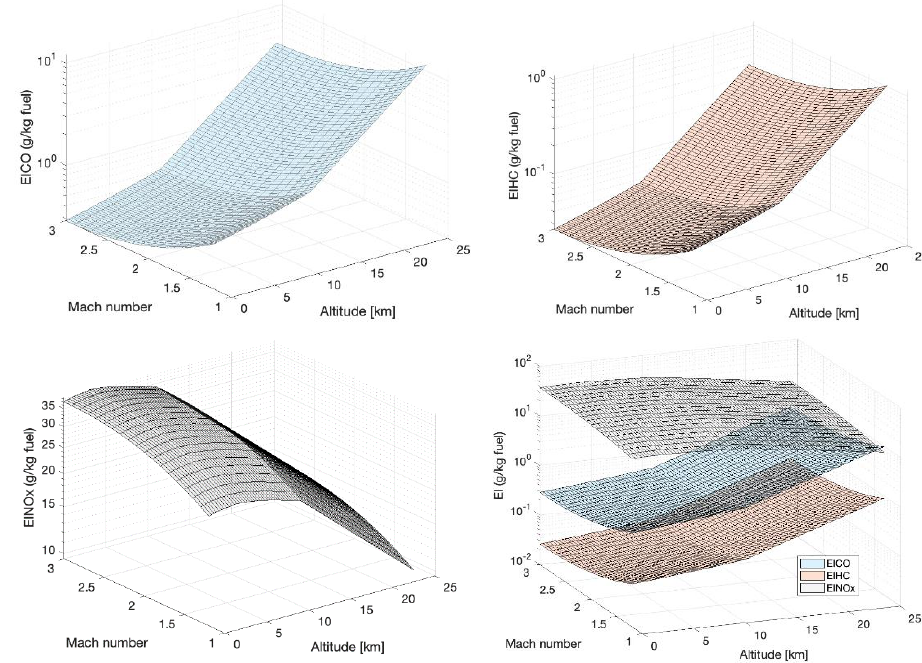
Figure 8. Emission indexes variation as function of cruise Mach numbers and altitude.